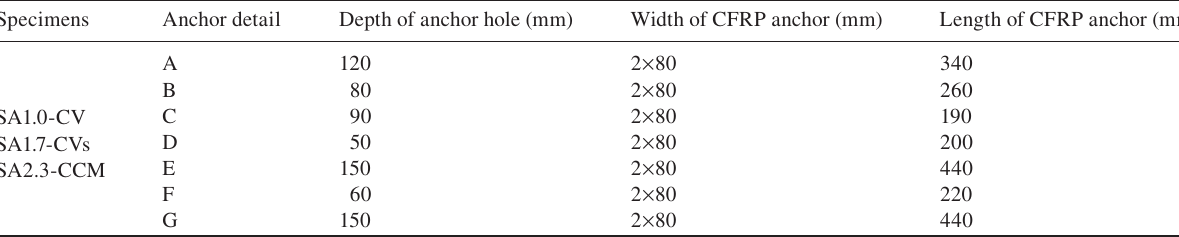
Table 2 CFRP overlay dimensions used for